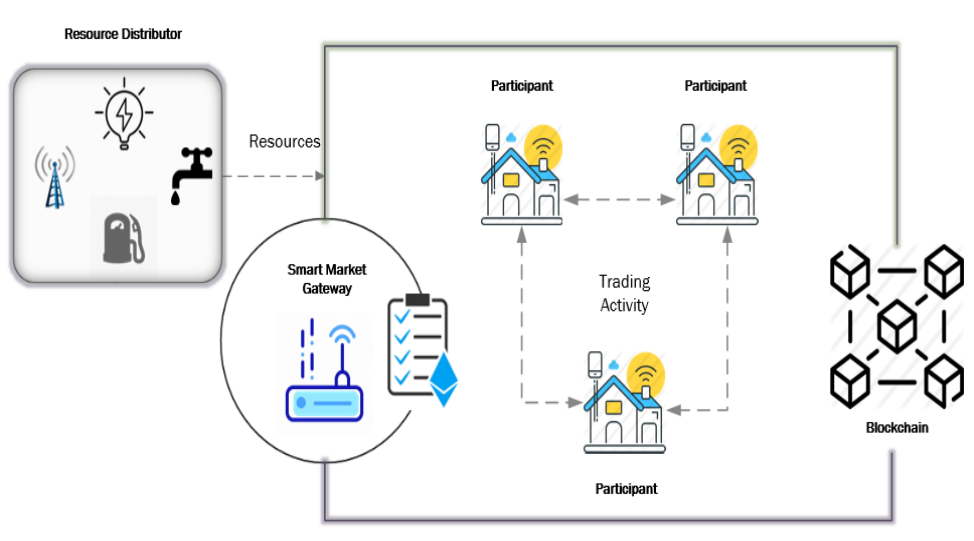
Figure 1. System